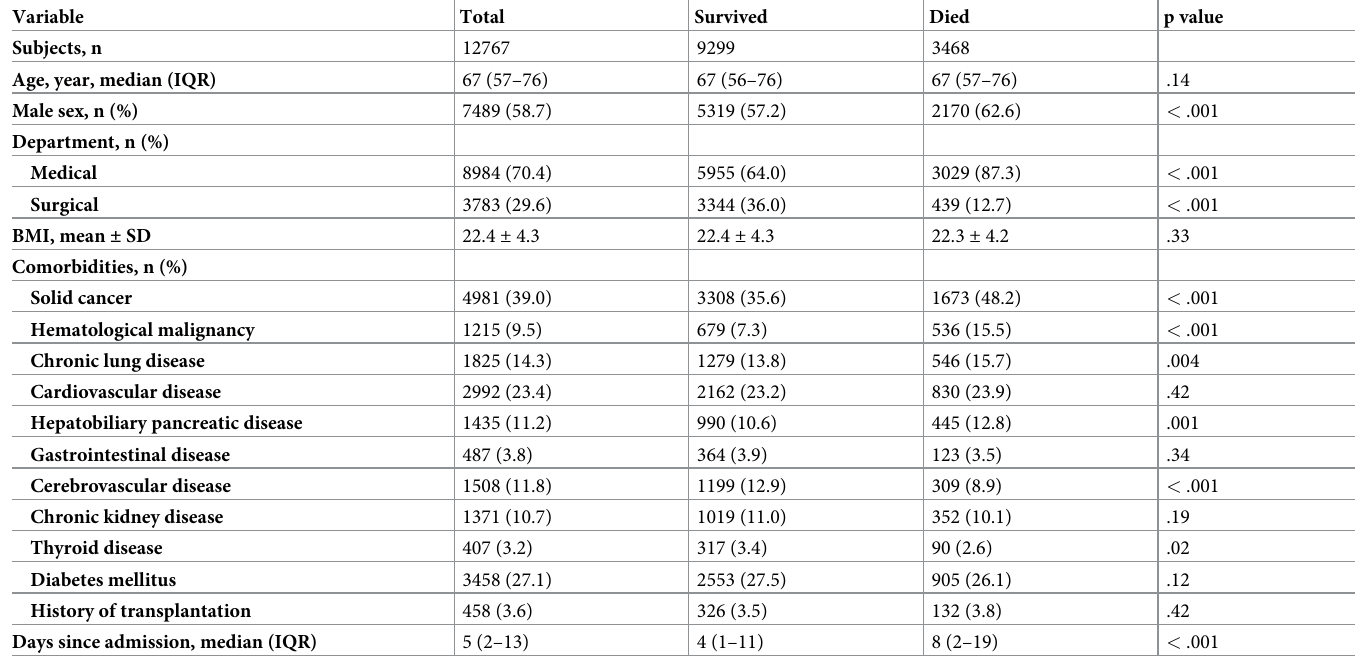
Table 1. Subject